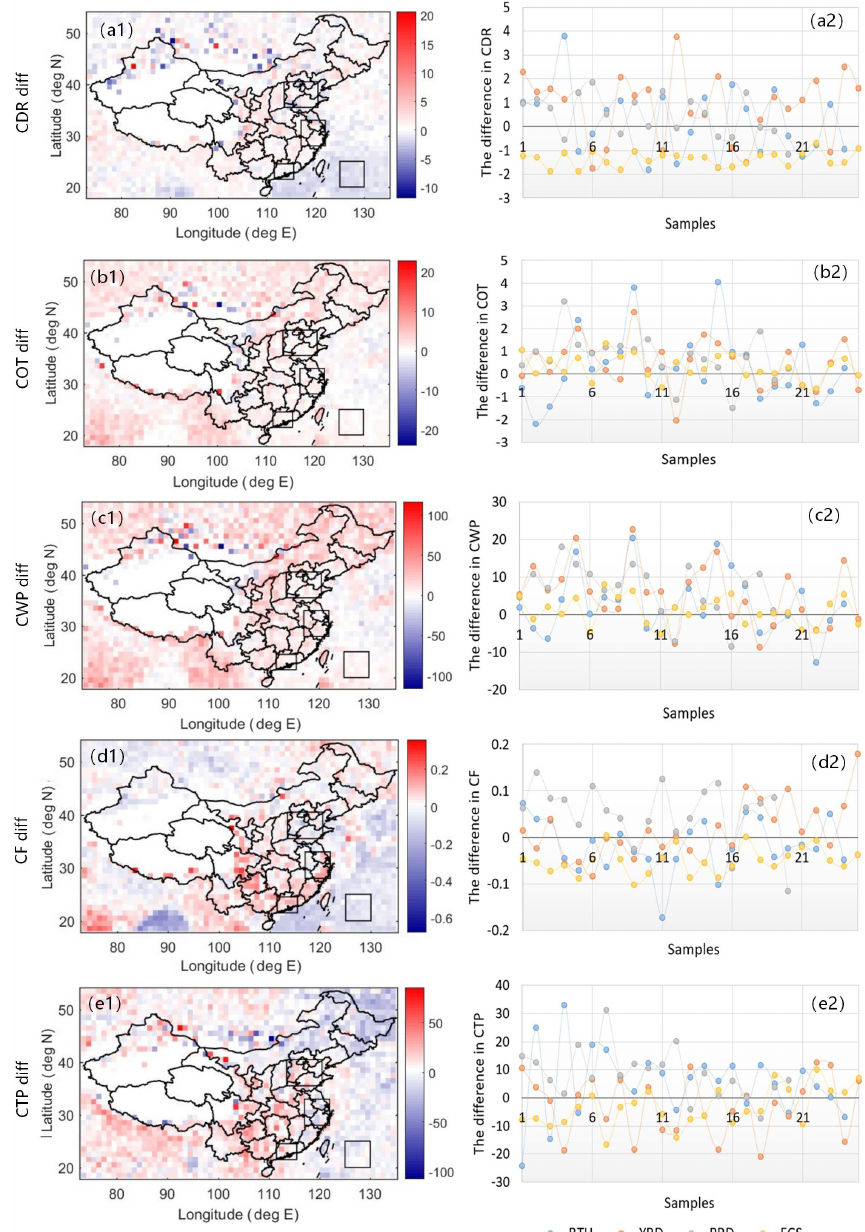
Figure 6. Spatial distributions of differences in cloud properties (CDR, COT, CWP, CF and CTP) between Aqua and Terra overpasses (3h) for the highest MODIS/Terra AOD quartiles (left, a1–e1 ). Sample series of the differences in cloud properties (CDR, COT, CWP, CF and CTP) between the values at the start time and the end time of the time step for the highest MODIS AOD quartiles (right, a2–e2